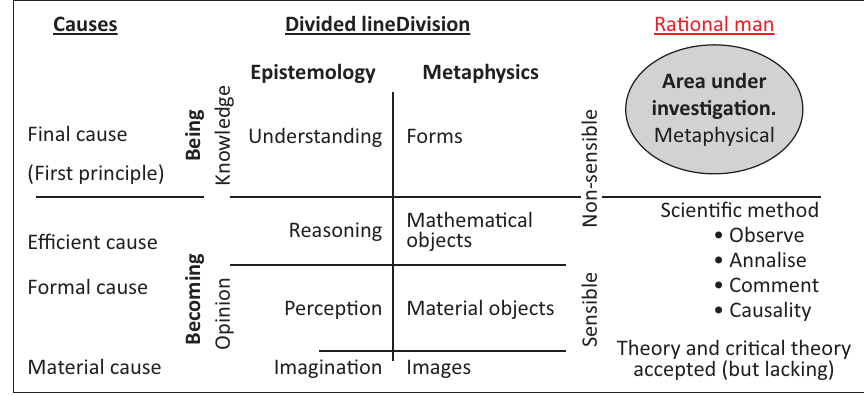
FIGURE 1: Philosophical